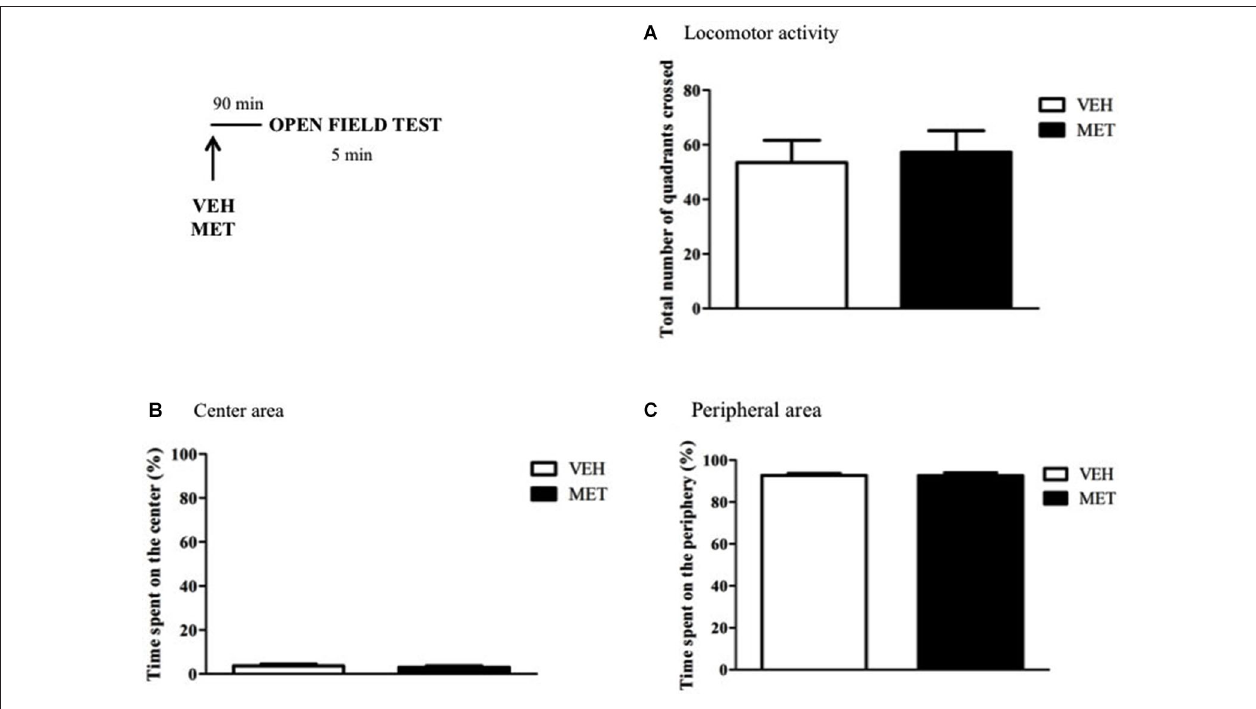
animal’s locomotor activity. (B) Time spent in the center of the arena. (C) Time spent in the periphery of the arena. VEH = vehicle group ( n = 5); MET = metyrapone group ( n =